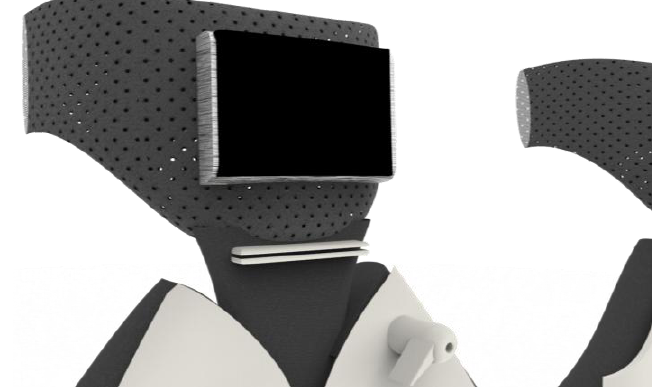
Figure 45. IFE (in-flight entertainment).